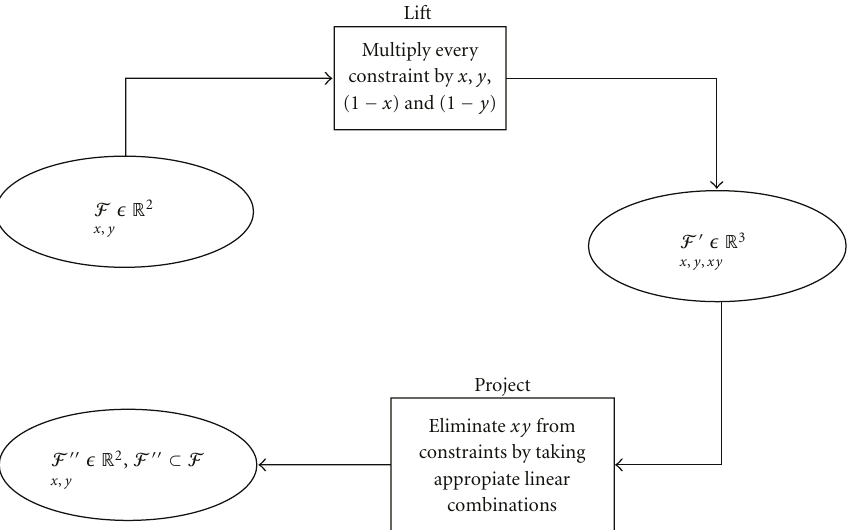
Figure 1: Illustration of lift-and-project method for a problem with 2 optimization